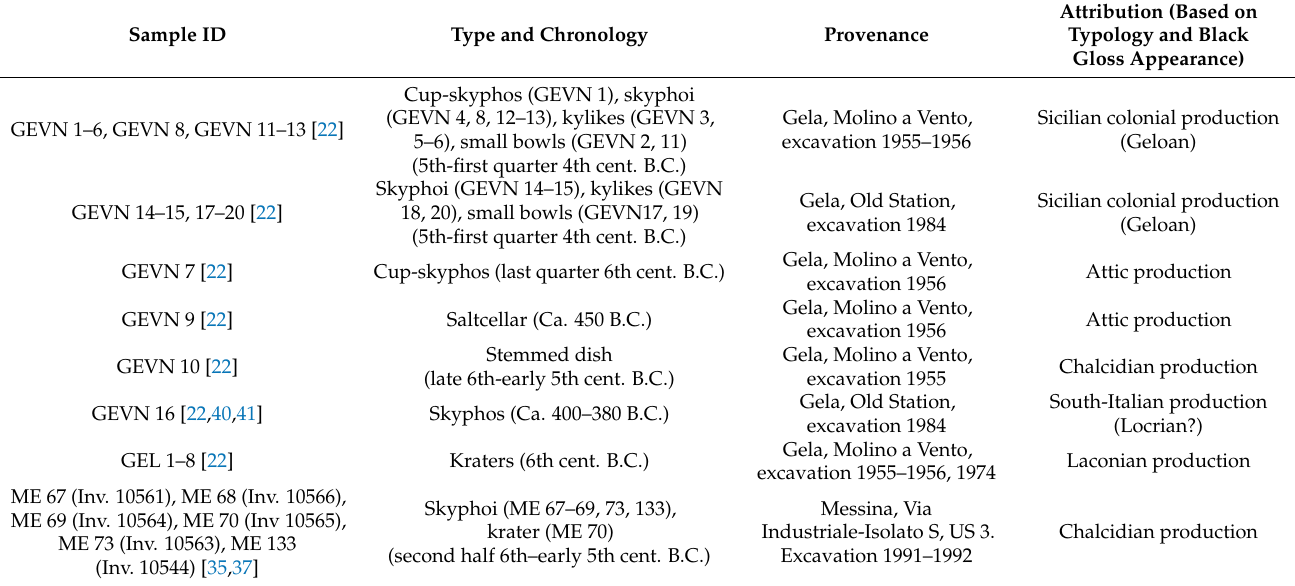
Table 2. List of studied